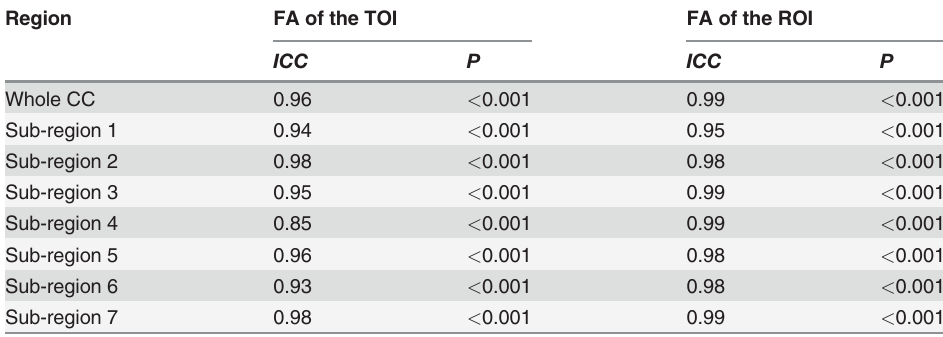
Table 1. Intra-rater reliability for FA values in corpus callosum.